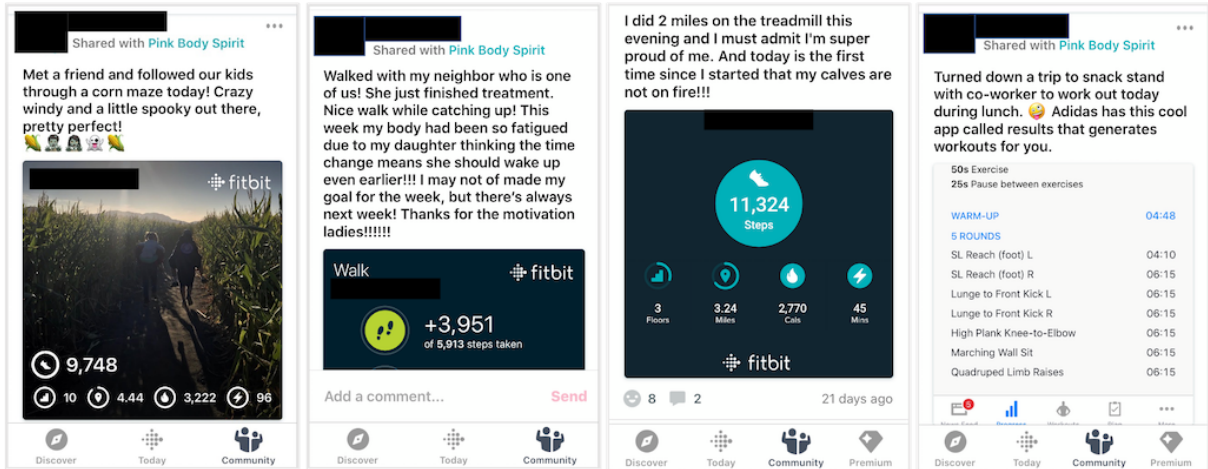
Figure 3. Sample posts from the private, in-app Pink Body Spirit Fitbit Community (note: app screenshots have been redacted to maintain